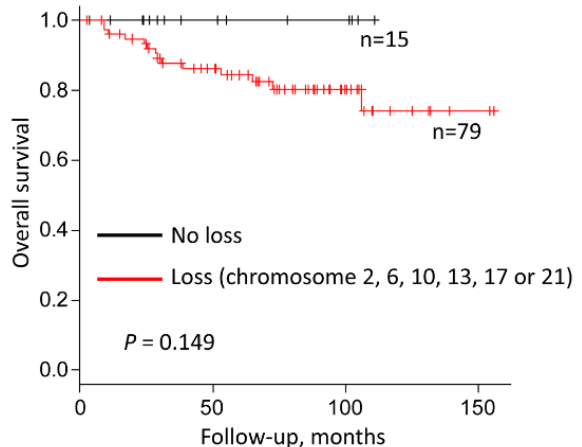
Figure 1. Combined survival analysis of chRCCs categorized by loss or no loss of chromosomes 2, 6, 10, 13, 17 and 21 (TCGA-KICH: No loss n = 12; Loss n = 52; Swiss cohort: No loss n = 3; Loss n = 27).